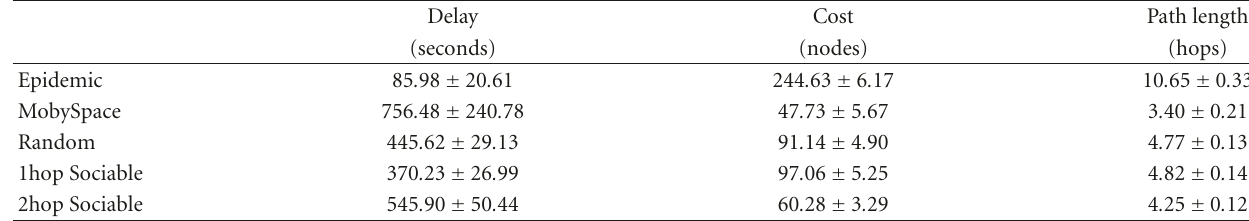
Table 1: Numerical results in terms of average delay, cost, and path length for the protocols considered.